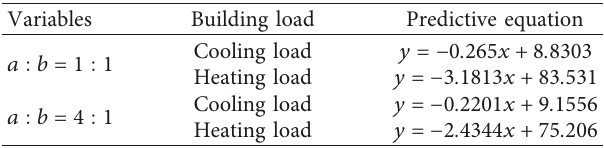
Figure 12: Cooling load related to the x value. Table 2: Predictive results of heating and cooling load according to variations in x